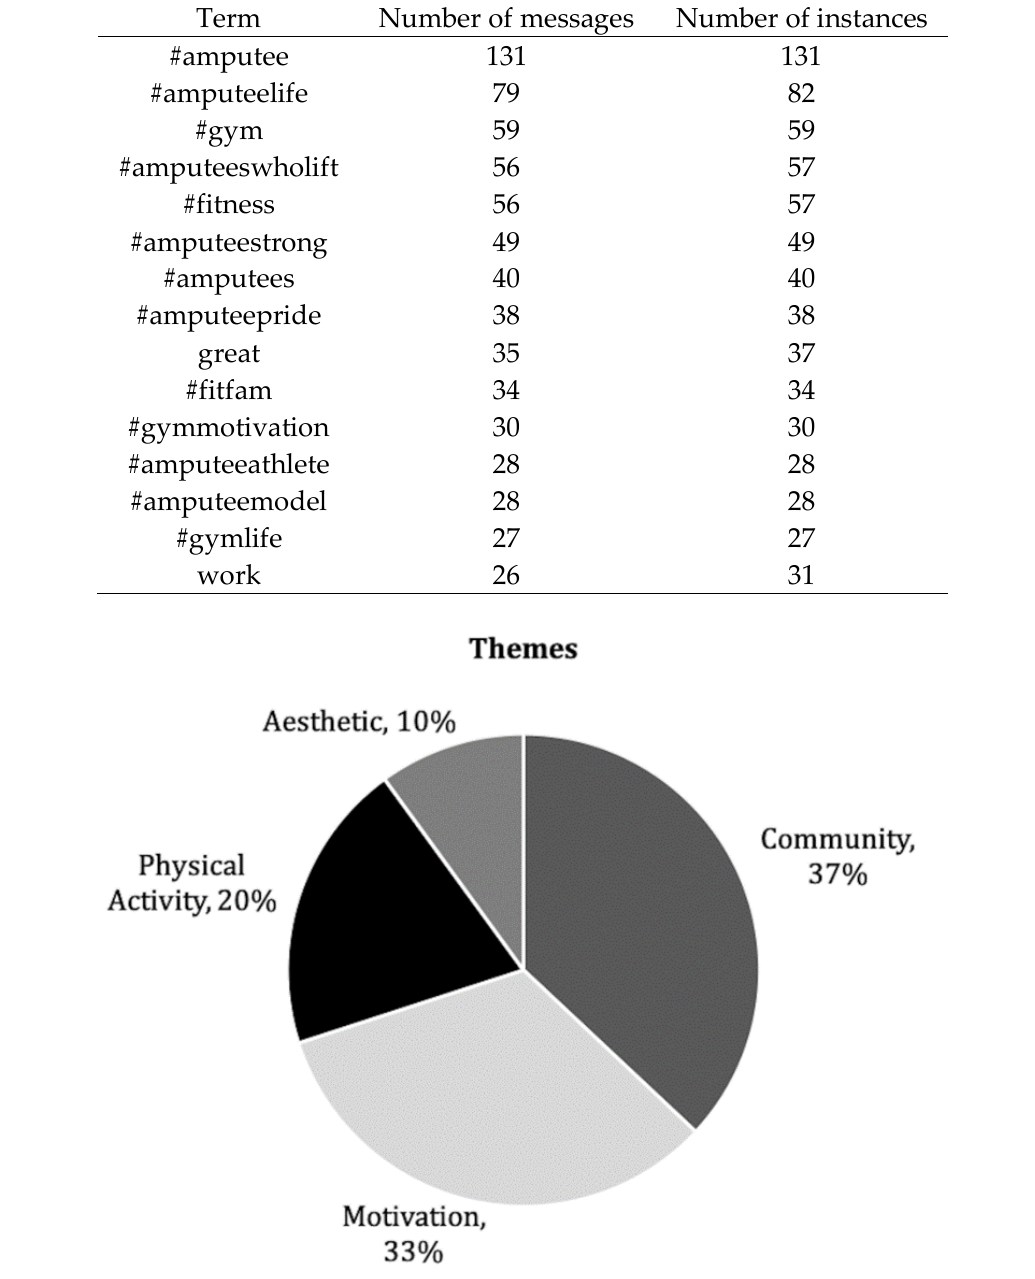
Figure 1. Categories of popular words or hashtags associated with #amputeefitness ( n =30). Image selection and coding of